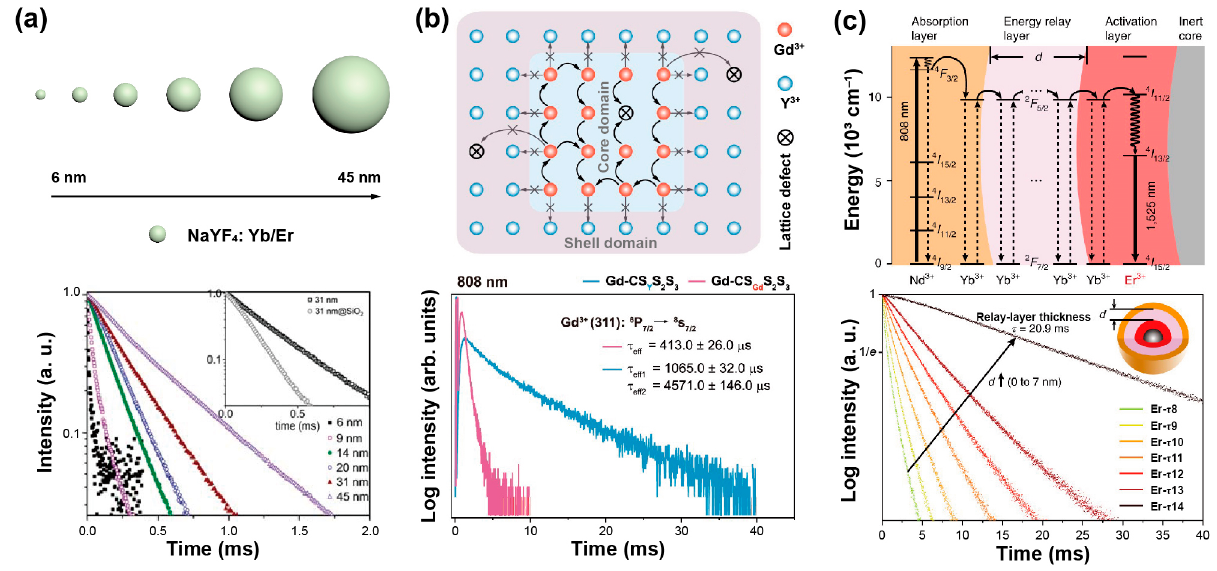
Figure 2. ( a ) The schematic description for the size of NaYF 4 :Yb,Er nanoparticles and lifetime decay curves of green emission in these nanoparticles. Reproduced with permission from [31]. Copyright 2013, Royal Society of Chemistry. ( b ) The diagram of energy transfer mechanism in NaGdF 4 :49%Yb,1%Tm coated with heterogeneous shell nanoparticle, and corresponding lifetimes of Gd 3+ in homogenerous and heterogeneous nanoparticles at 310 nm under 808 nm excitation. Reproduced with permission from [38]. Copyright 2021, Nature Publishing Group. ( c ) The diagrammatic drawing of energy transfer process in the core–multishell nanoparticles and luminescence decay curves at 1525 nm with the energy relay shell thickness ranging from 0 to 7 nm. Reproduced